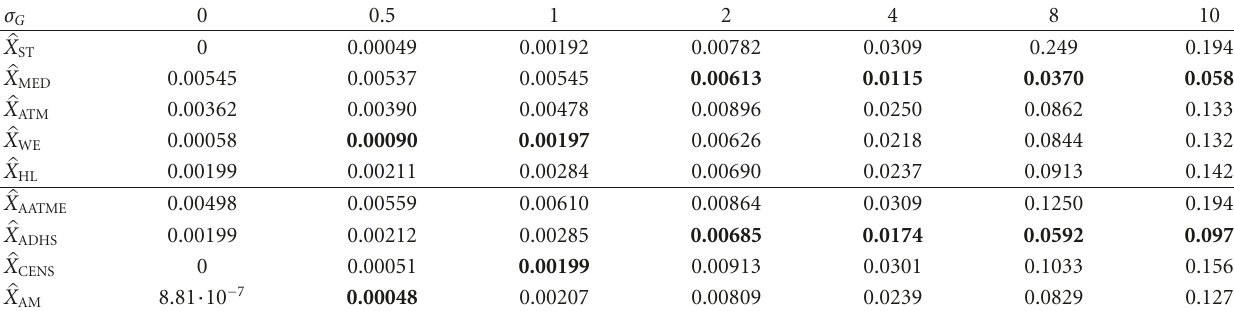
Table 3: MSE values of spectrum estimation for TS s 1 ( n ) corrupted by additive Gaussian noise.